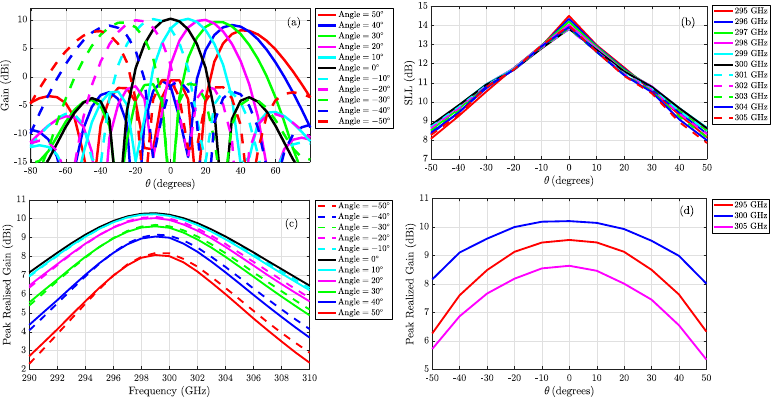
Figure 10. ( a ) Steering pattern for 1 × 4 array at 300 GHz, ( b ) SLL of array, ( c ) peak realised gain vs. fre- quency for varying steering angles, ( d ) peak realised gain vs. steering angle for different